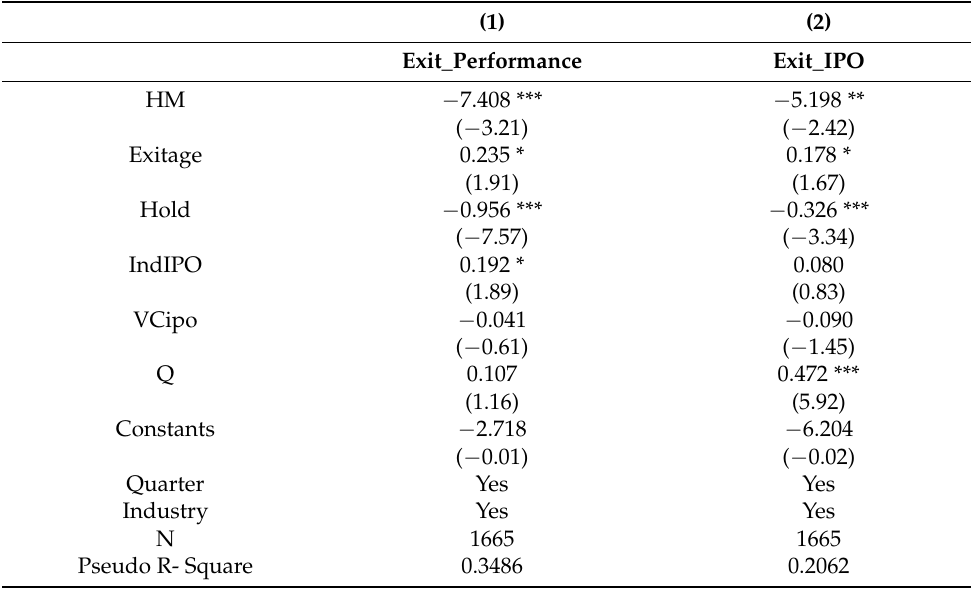
Table 7. The consequences of herding among venture